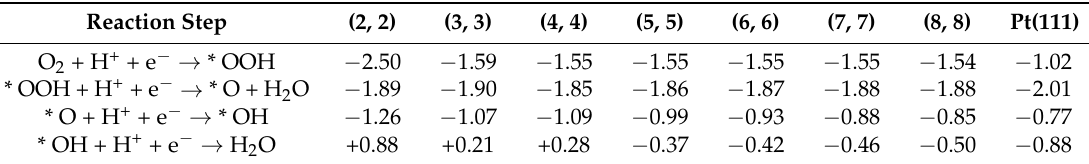
Table 1. Calculated reaction energy changes (unit: eV) for each electron transfer step on Fe − N 4